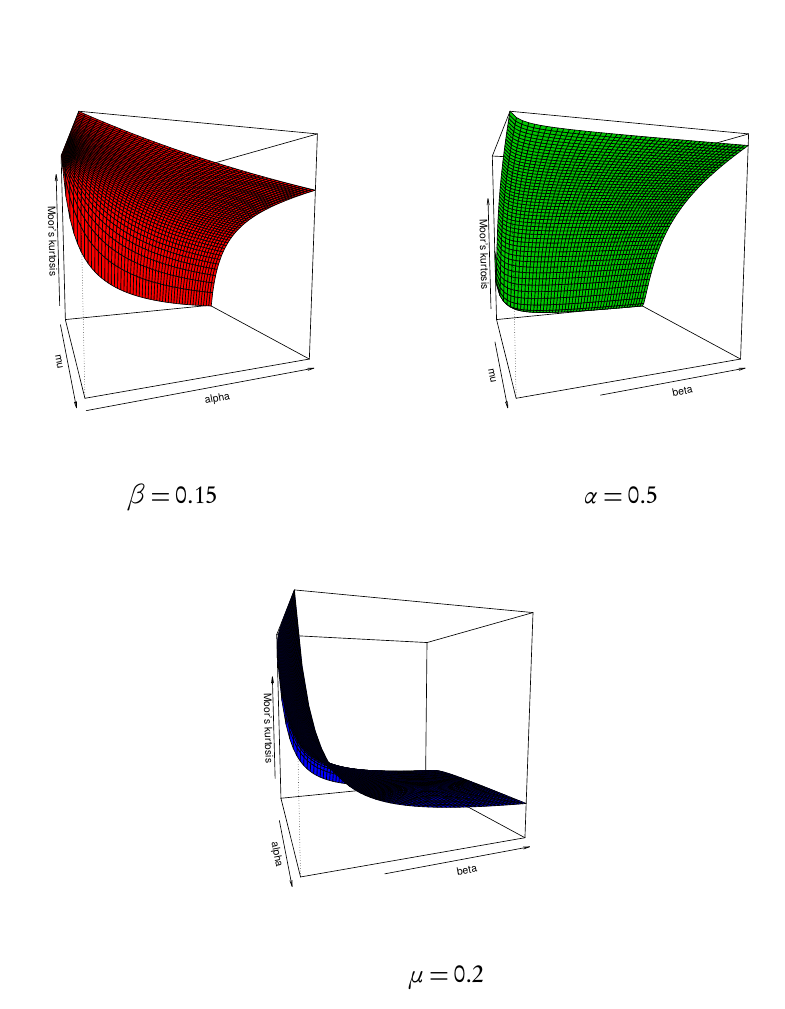
Figure 4 – The 3D plots of the Moor’s